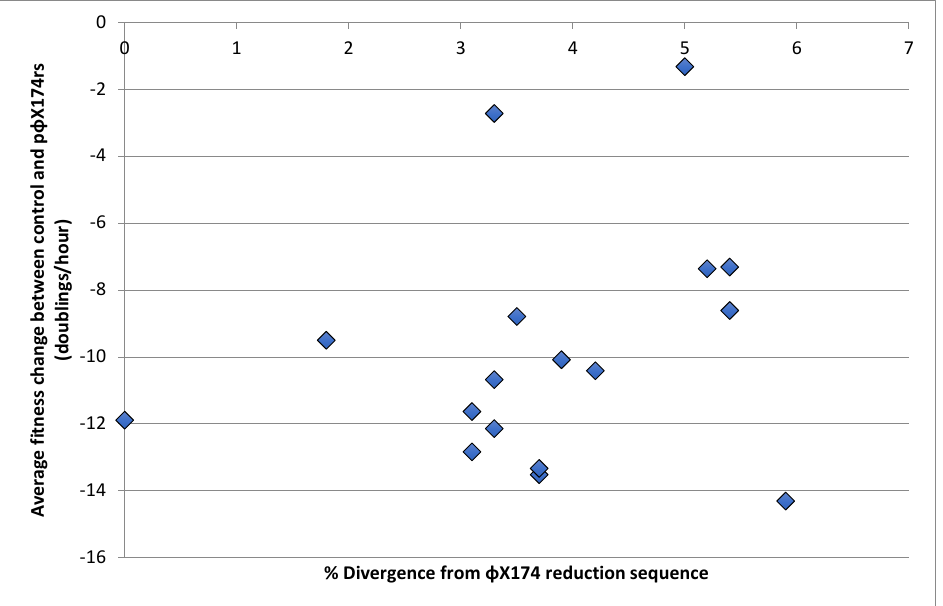
Figure 3. Difference between the fitness of wild phages with the control plasmid and the ΦX174rs plasmid plotted against the divergence of those phages from ΦX174 in the region of the reduction sequence. Spearman’s correlation analysis between percent divergence and fitness change indicated that overall divergence does not have an impact on the inhibition by the ΦX174 reduction sequence (r = 0.23).